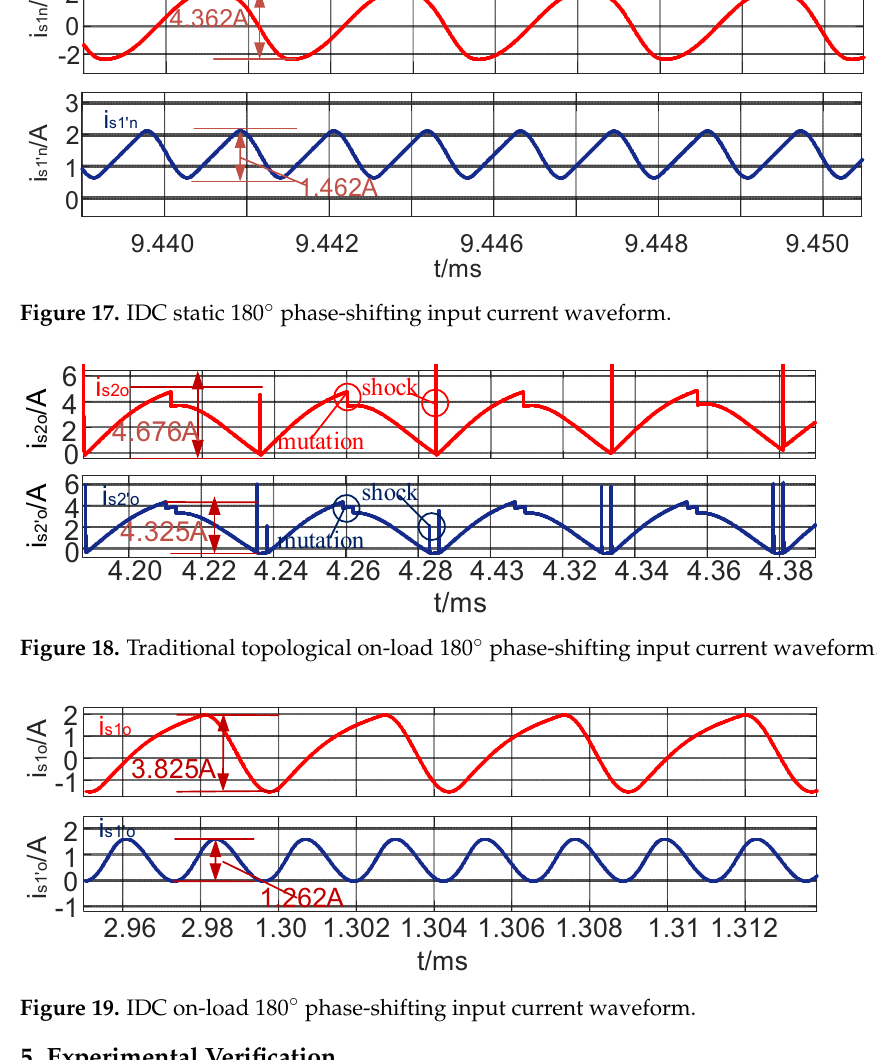
Figure 17. IDC static 180° phase-shifting input current waveform .